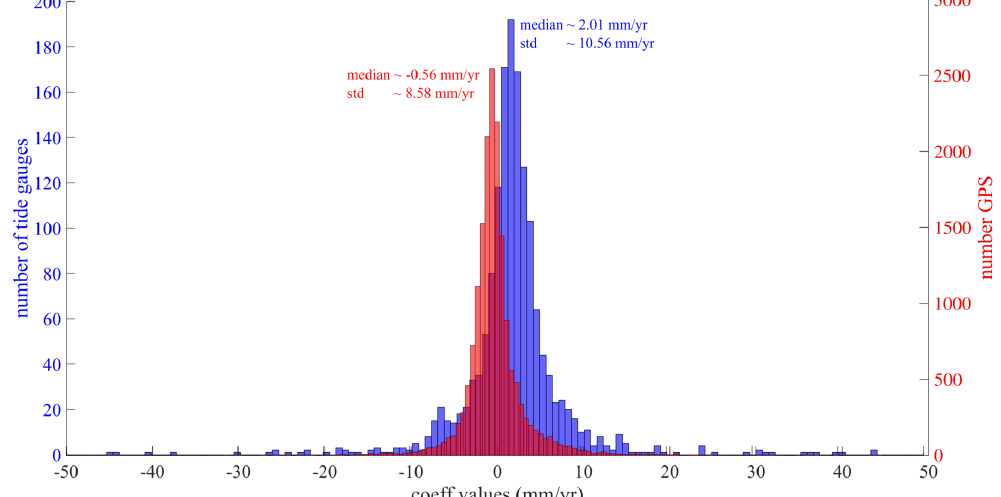
Figure 6. Superposition of the histogram of recent slopes of 1548 tide gauges with that of the MIDAS (GPS) data (from Hammond et al. [8])